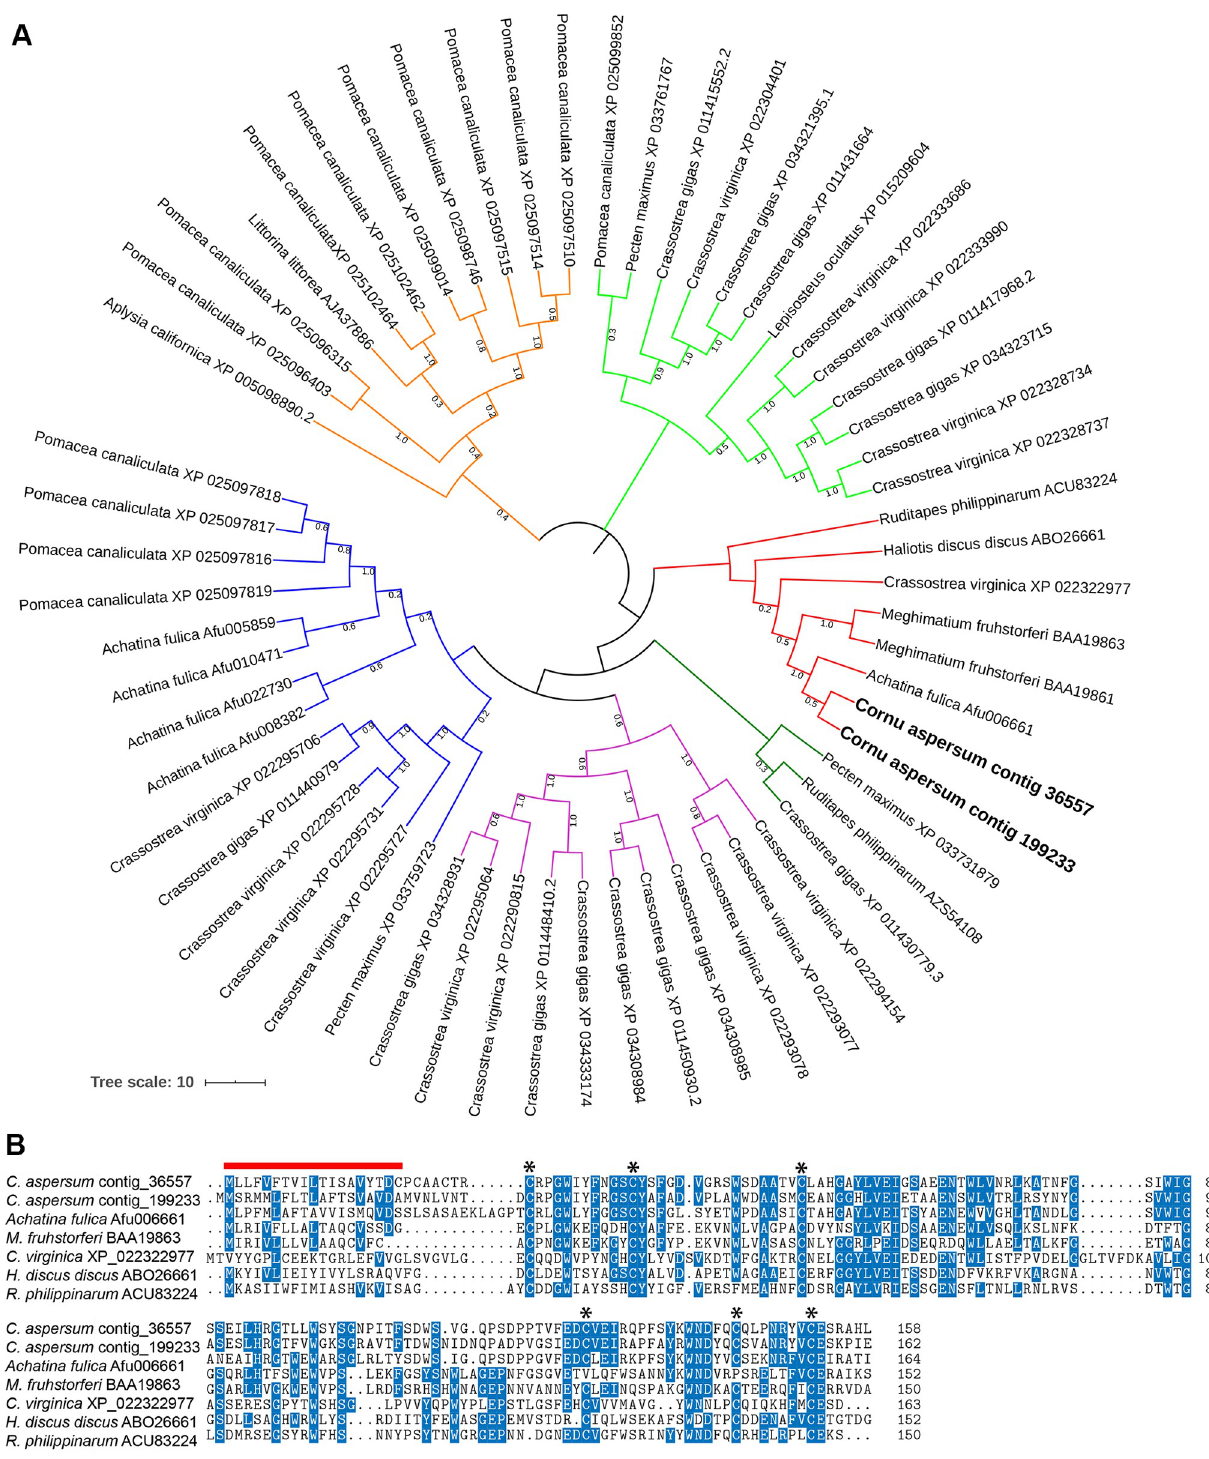
Fig 4. Comparative analysis of perlucin-like proteins. (A) Phylogenetic tree showing 6 clusters of perlucin-like proteins (colour-coded), including two found in Cornu aspersum (red cluster). (B) Multiple protein sequence alignment of mature perlucin-like proteins represented in phylogenetic cluster with Cornu aspersum . Shading and sequence logo (above alignment) provides level of conservation between species.